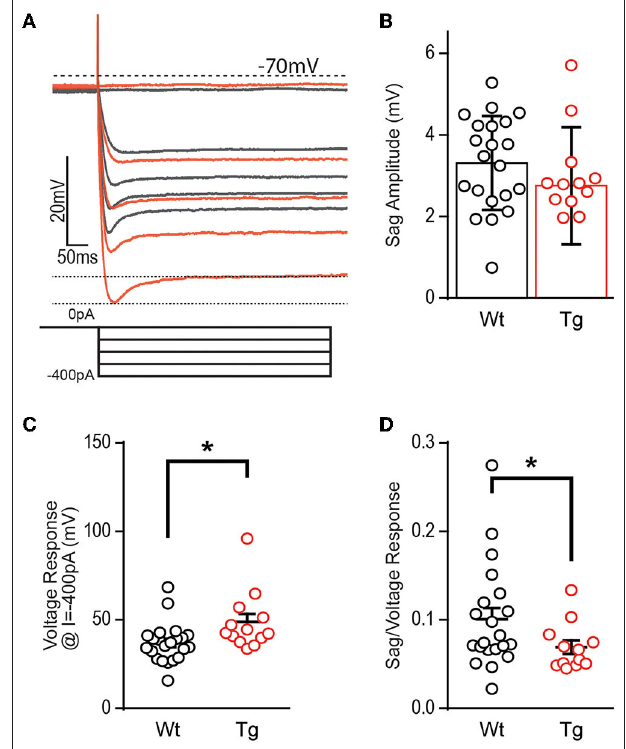
FIGURE 4 | Voltage sag potential is decreased in TgF344-AD DGCs. (A) Example trace of “sag” current measurements taken at − 400pA current injection. (B) The raw amplitude of the sag current is not different between TgF344-AD and Wt littermate DGCs (Wt, n = 21 cells/8 animals; Tg, n = 12 cells/6 animals; p > 0.05). (C) The voltage response at − 400pA is greater in TgF344-AD rats (Wt, n = 22 cells/8 animals; Tg, n = 13 cells/6 animals; * p < 0.05). (D) When sag amplitude is normalized to voltage response a significant deficit in TgF344-AD DGC sag is unmasked (Wt, n = 21 cells/8 animals; Tg, n = 12 cells/6 animals; * p < 0.05). Data represent mean ± SEM. Significance is determined using the unpaired Student’s t